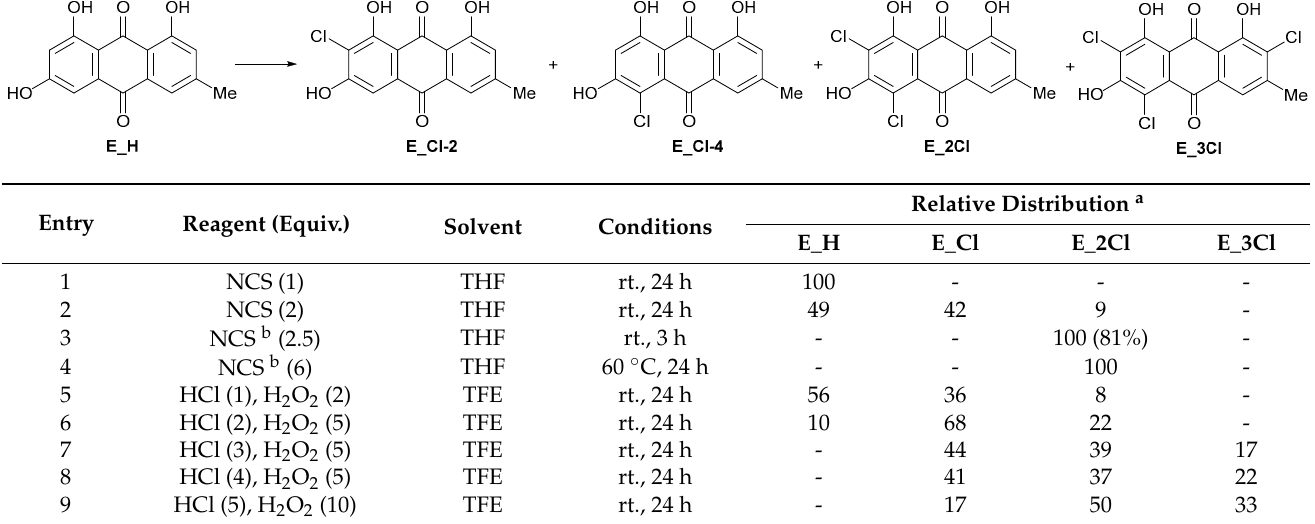
Table 3. Chlorination of emodin E_H with NCS and HCl/H 2 O 2 .